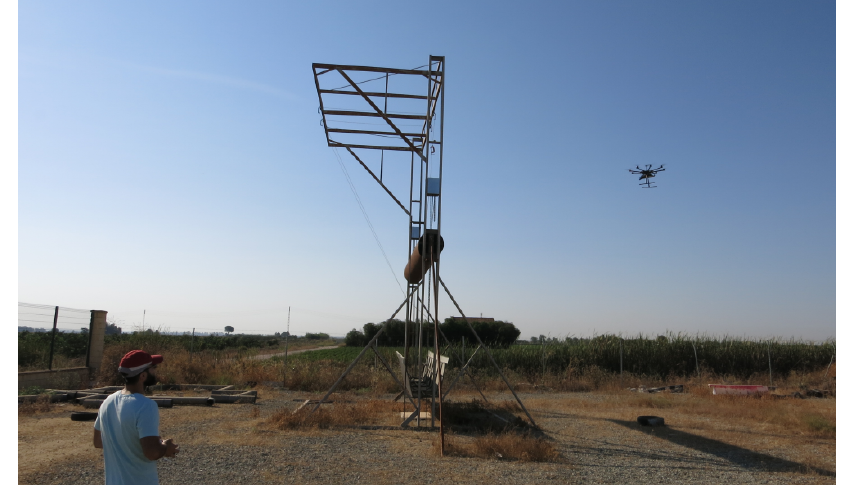
Figure 4. The outdoor setting for real flights using the UAV in Figure 3, the obstacle to avoid, and the safety